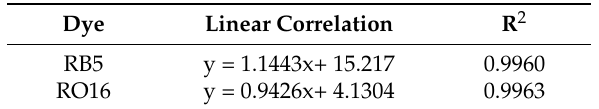
Table 3. Correlation between dye removal and lignin-METAC concentration.